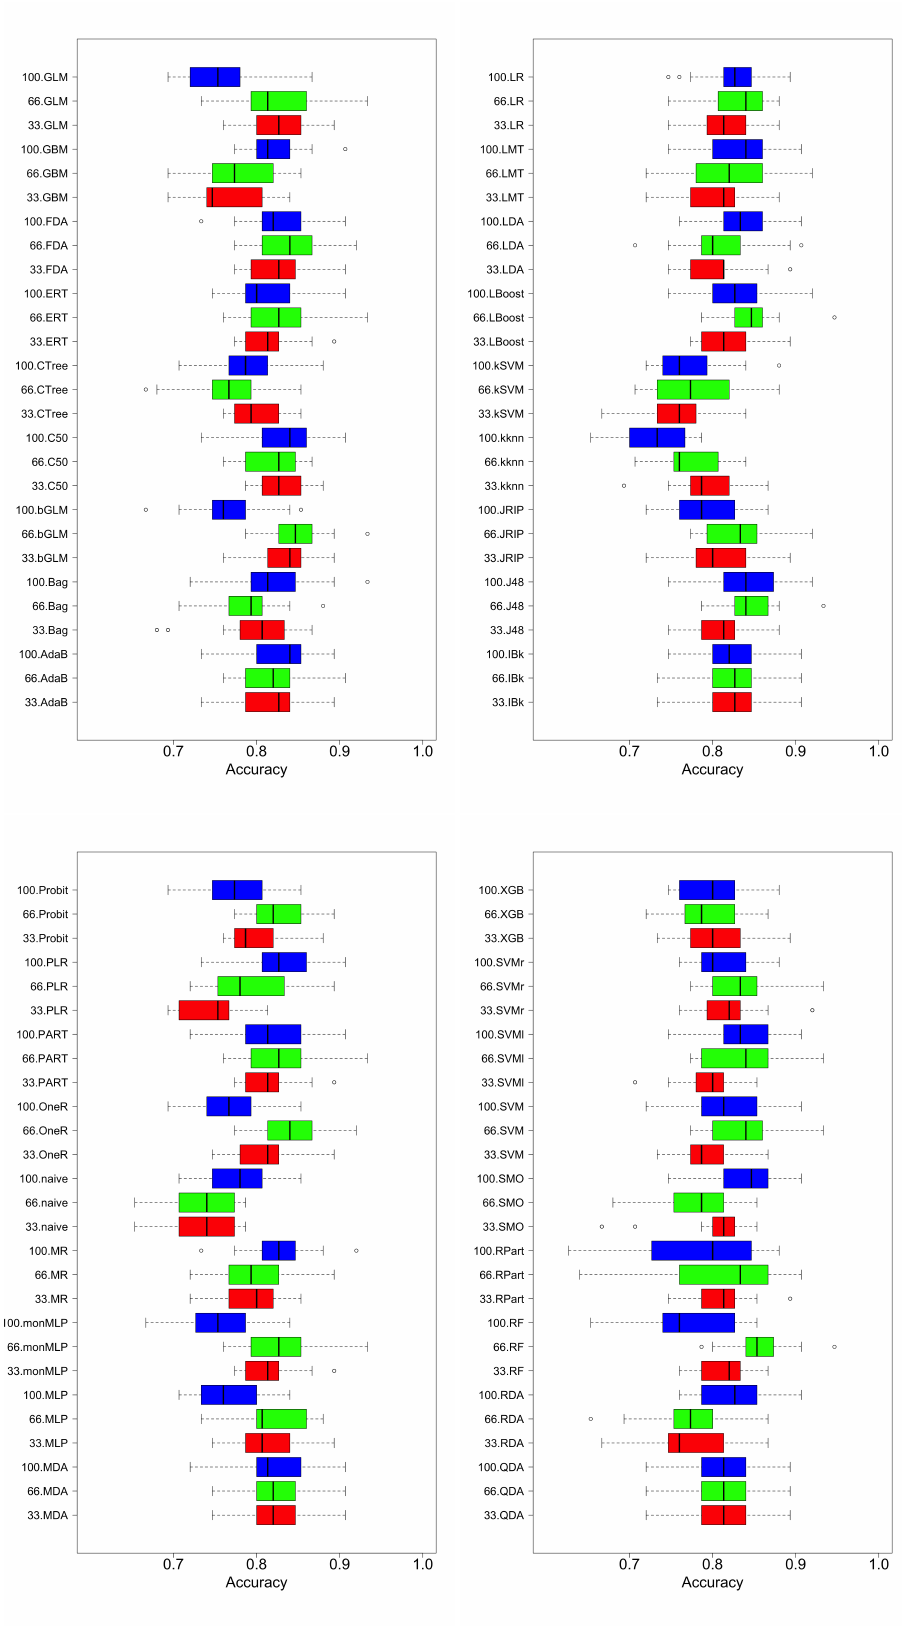
Figure 4. Comparison of classifier performance (accuracy). Blue, all features; green, best 66% of features; red, best 33% of